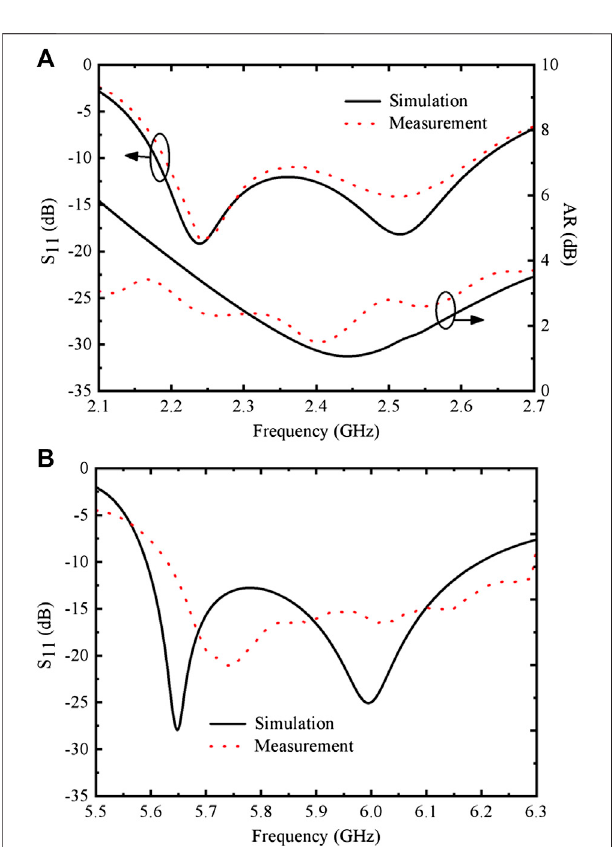
FIGURE 4 | Simulated and measured S-parameters and ARs: (A) low band; (B) high